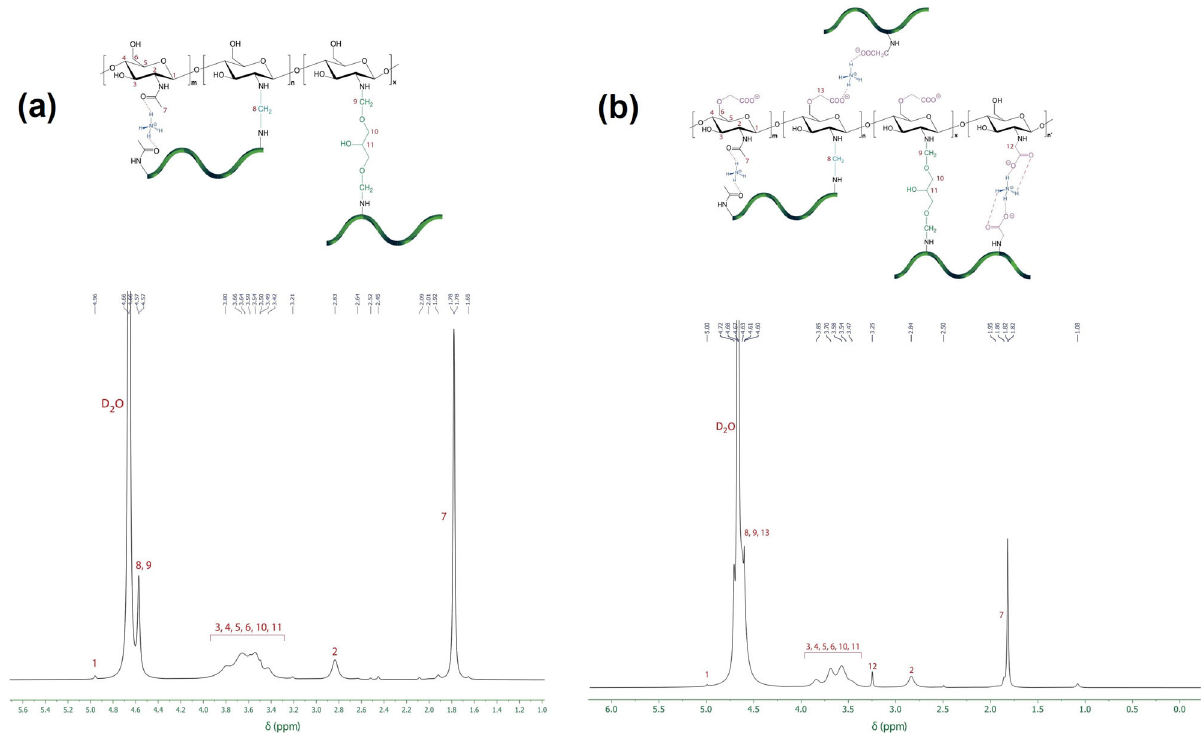
Fig. 4 1 HNMR spectra of hydrogels. a CS-g-gly and ( b ) CMCS-g-gly (500 MHz, D2O, 25 °C).